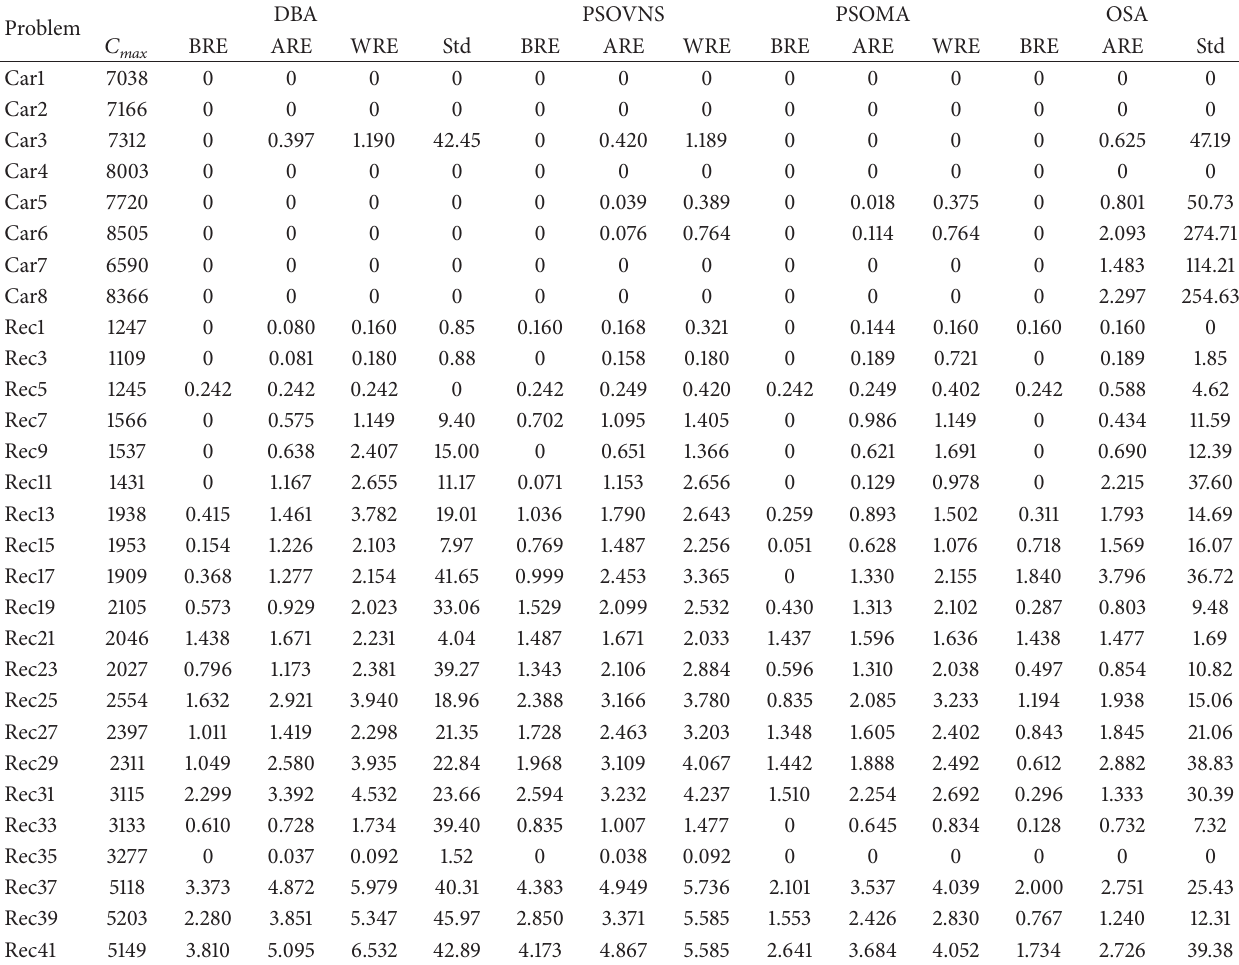
Table 2: Statistical performances of DBA, PSOMA, PSOVNS, and OSA.